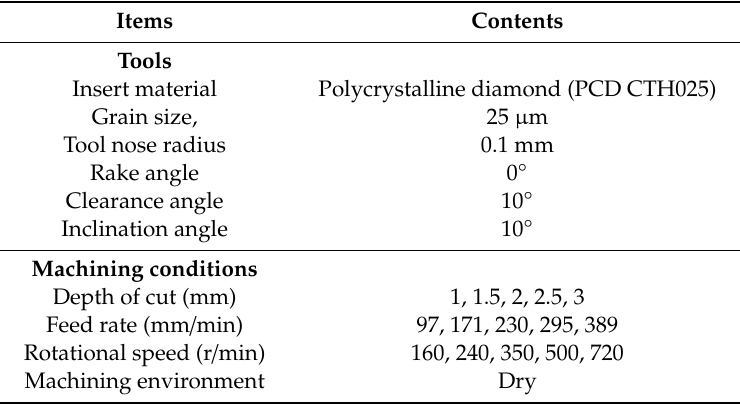
Table 2. Summary of experimental